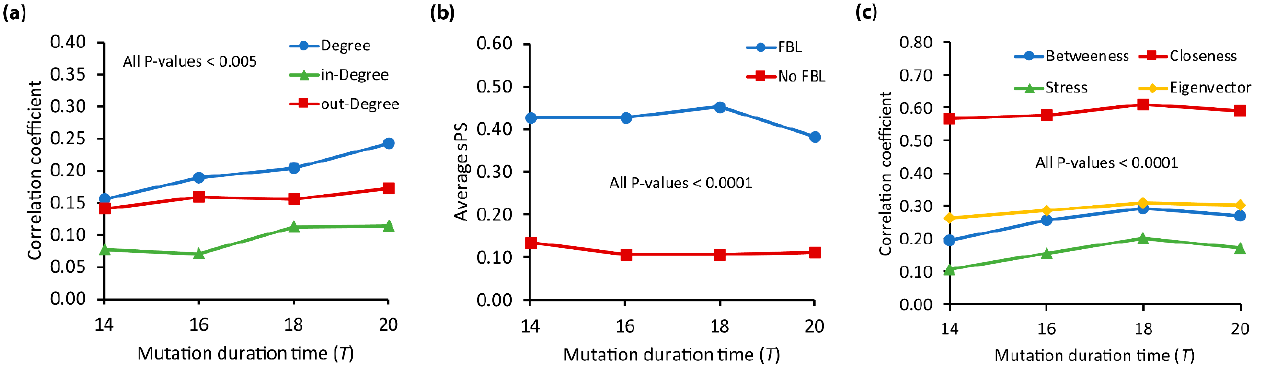
Figure 4. Relation of sPS with structural characteristics in KEGG network. ( a ) Relation to the degree. Y -axis values mean the correlation coefficients between sPS and the number of nodes’ degree, in- degree, and out-degree. ( b ) Relation to the involvement of feedback loops. All genes were classified into ‘FBL’ and ‘No FBL’ groups, where a gene involves any feedback loops or not, respectively. Y -axis values mean the average of sPS values. ( c ) Relations to the centrality measures such as betweenness, stress, closeness, and eigenvector. Y -axis values mean the correlation coefficients between sPS and each centrality measure. Mutation duration time T was set to